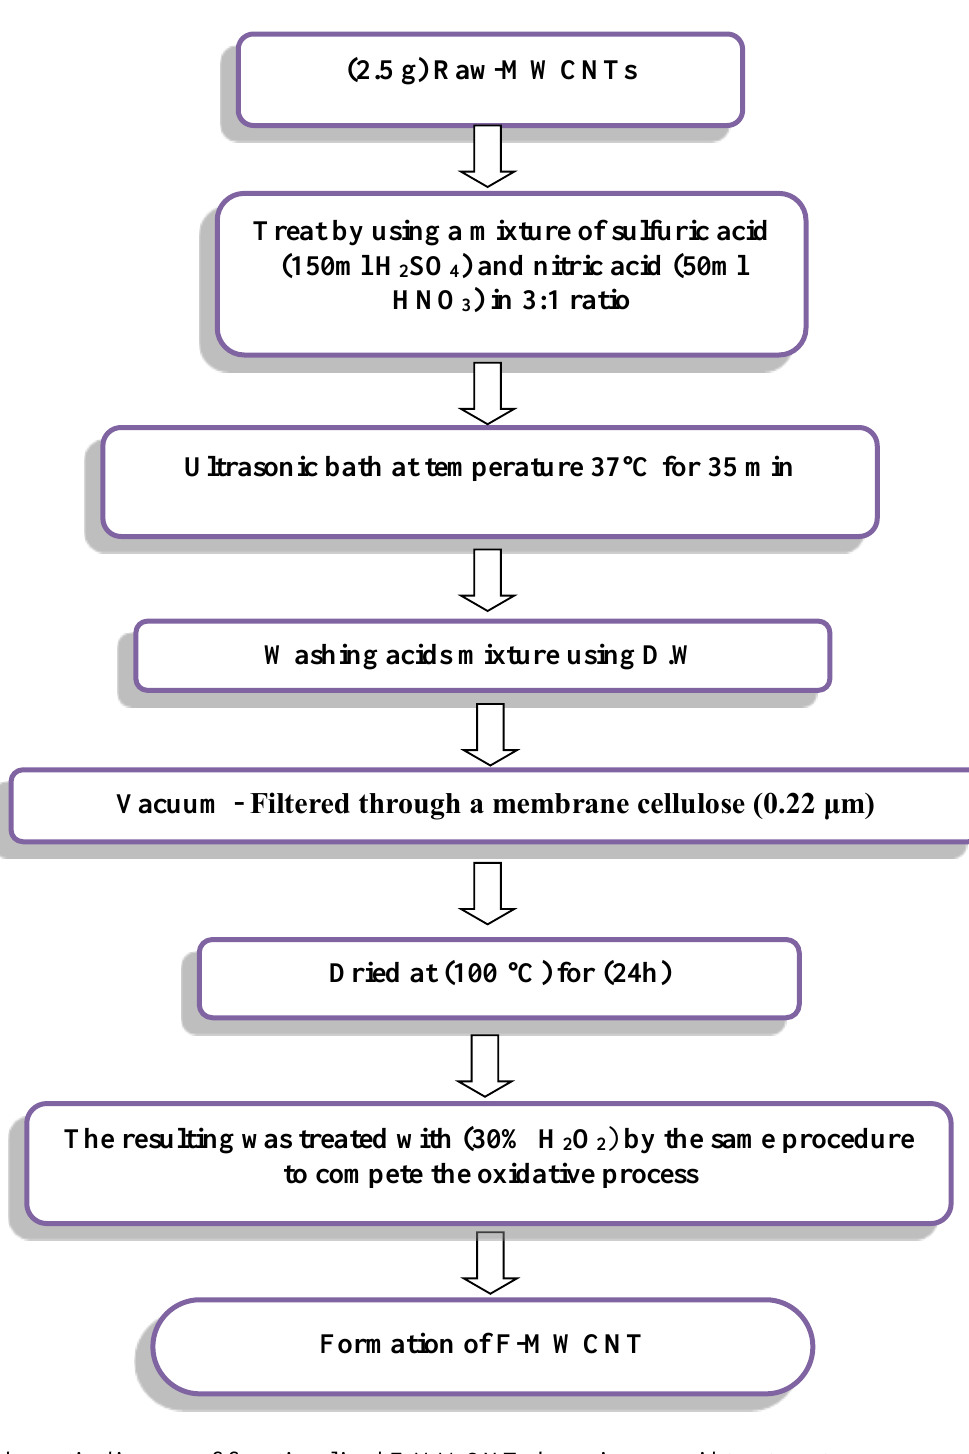
Figure 1 : Schematic diagram of functionalized F-MWCNTs by using an acid